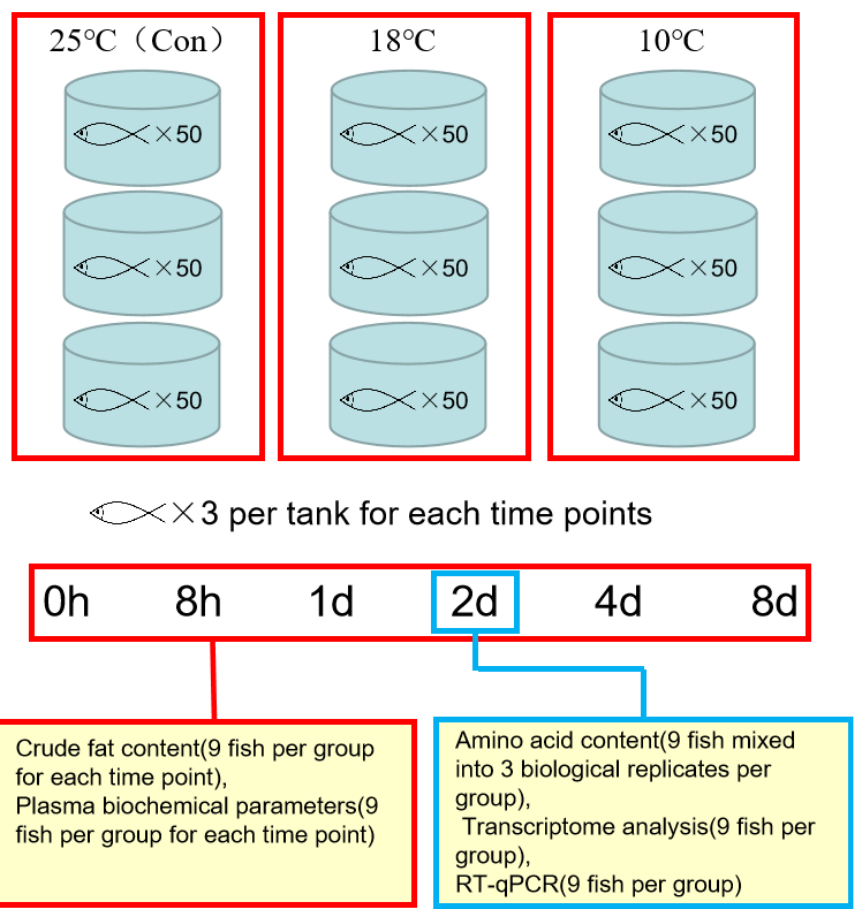
Figure 1. Overview of the experimental outline.